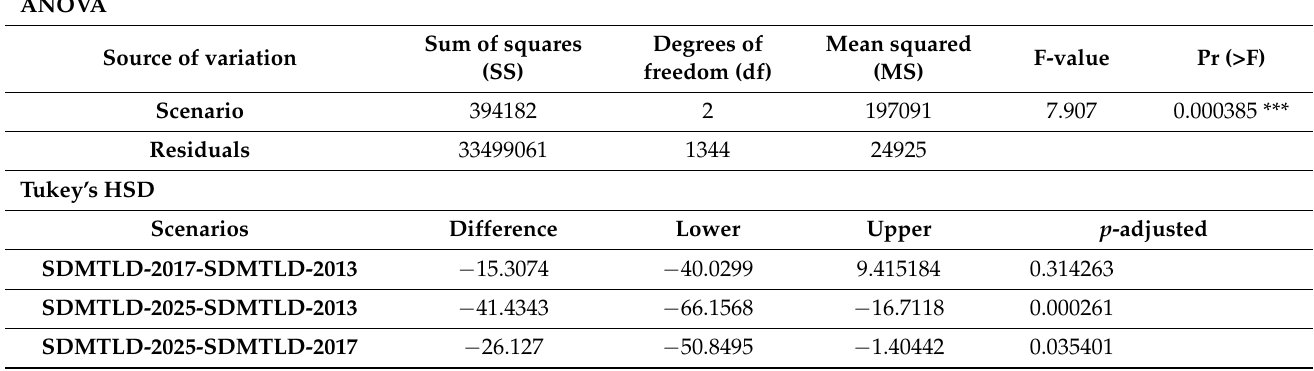
Table 5. Analysis of variance (ANOVA) test and Tukey’s honestly significant difference (Tukey’s HSD) post hoc test for pairwise comparisons of the sediment load under different scenarios.